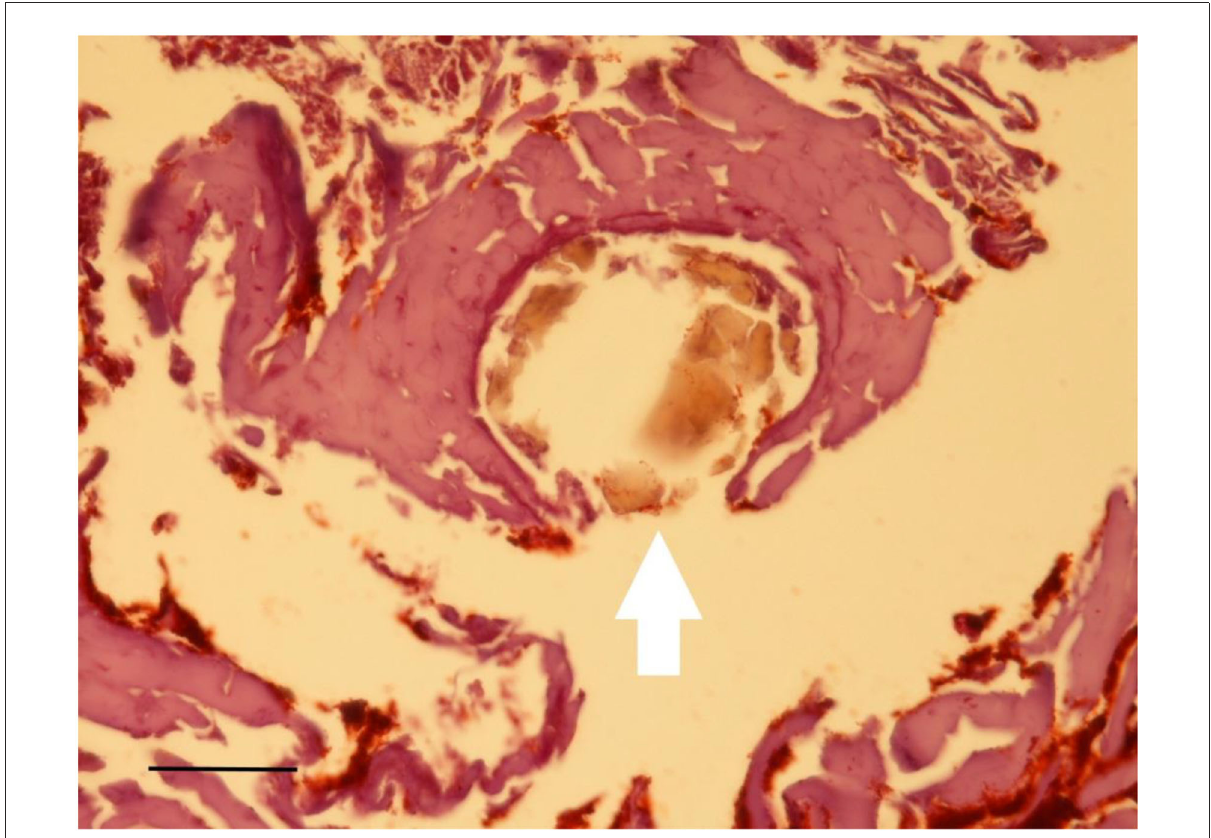
FIGURE13 Histological examination of the subcutaneous skin sample. Occasional inclusion of a hair shaft with dark pigmentation (arrow) (Staining: H&E; bar: 25 µ